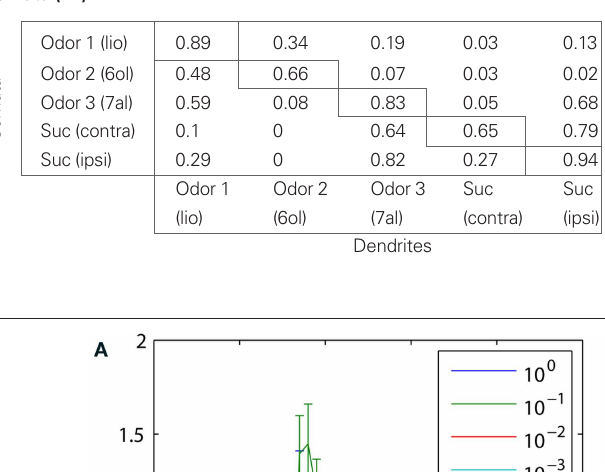
Table 1 | Correlation between odor responses in dendrites and somata ( R 2 ).